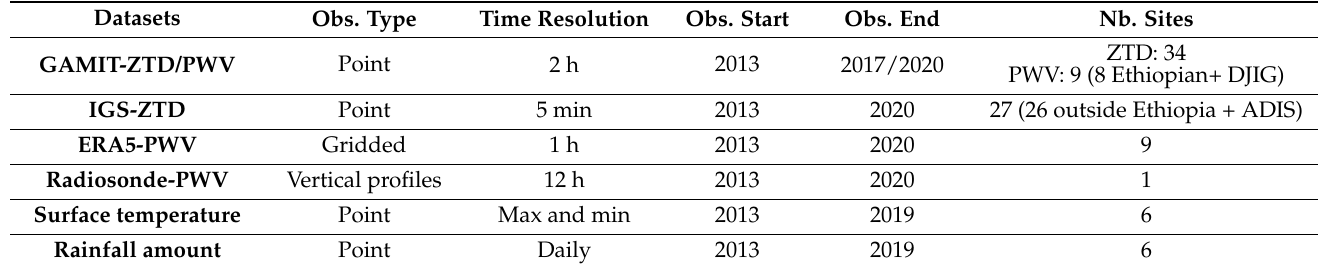
Table 4. Summary of the datasets and their